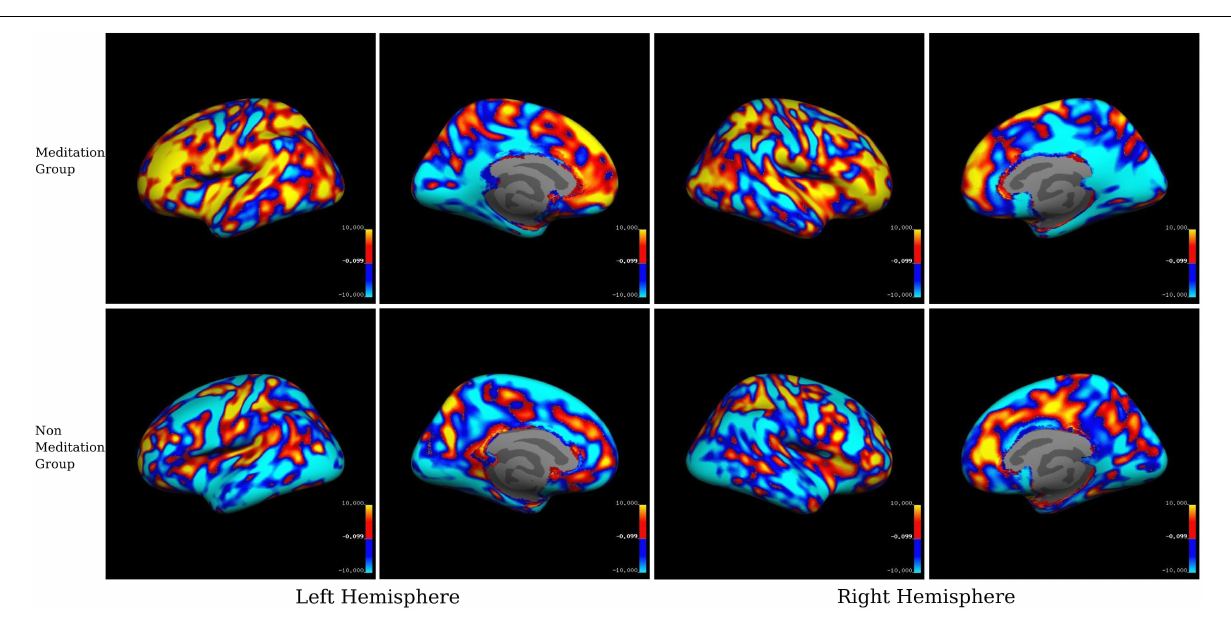
FIGURE 4 | Within-group averaged SPC changes for gray matter volume in the meditation (Group1) and the non-meditation (Groups2+3) groups. Positive values (red-yellow) corresponds to the increased gray matter volume and negative values (light blue-dark blue) corresponds to decreased gray matter volume. The voxels with SPC between –0.1 and +0.1 have been left uncolored. The top panel represents the meditation group while the lower panel represents the non-meditation